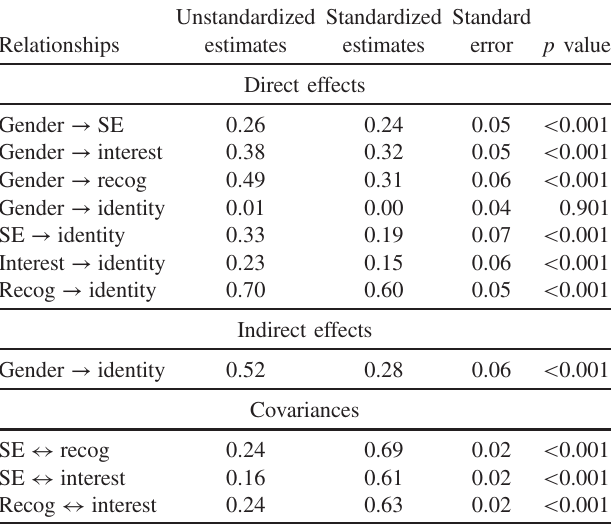
TABLE V. Results of the path analysis part of SEM model 1 for physics 2. Recog represents perceived recognition. SE represents self-efficacy. Single-headed arrows represent direct or indirect regression relationships. Double-headed arrows re- present